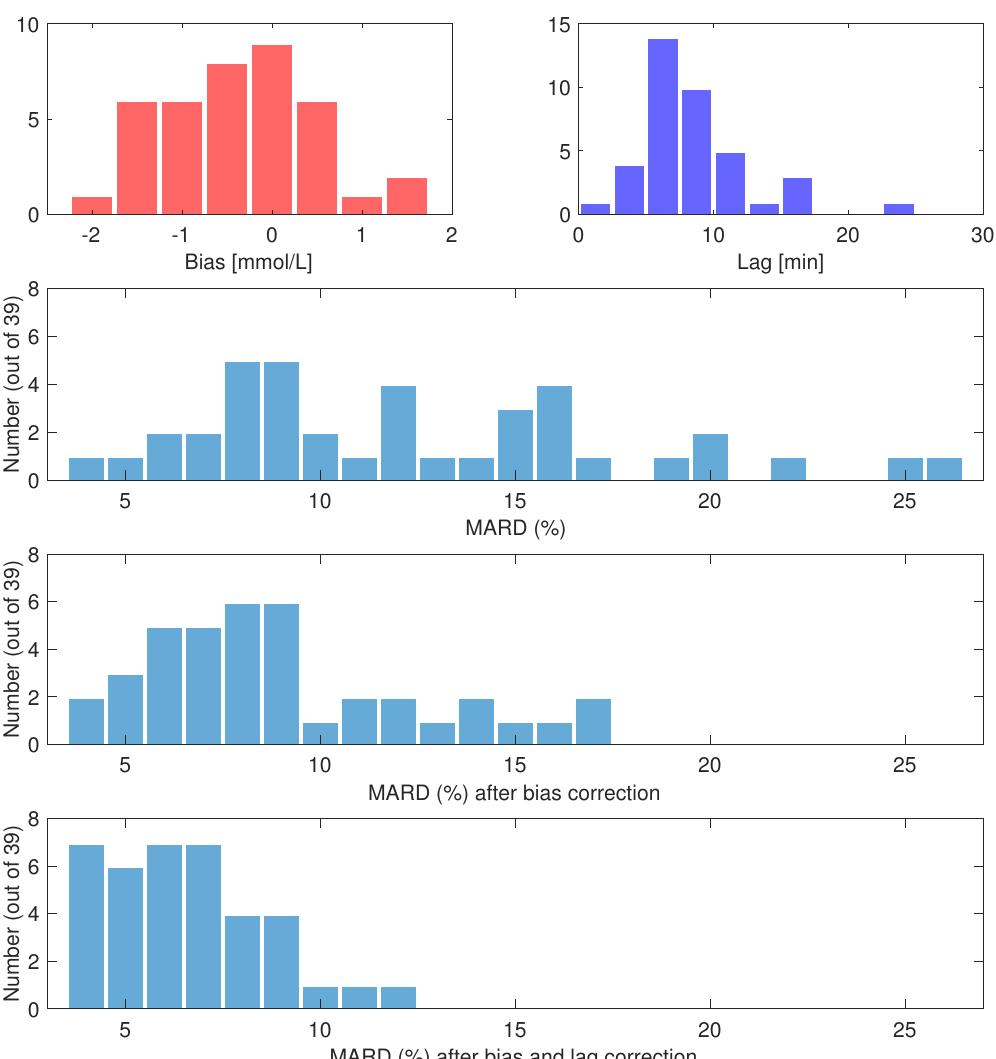
Figure 4. Histograms from day 1. Upper left: Estimated individual biases, b FGM . Upper right: Estimated individual time constants, τ i . Second row: individual MARDs, uncorrected. Third row: individual MARDs, bias corrected. Bottom row: individual MARDs, bias and lag corrected.